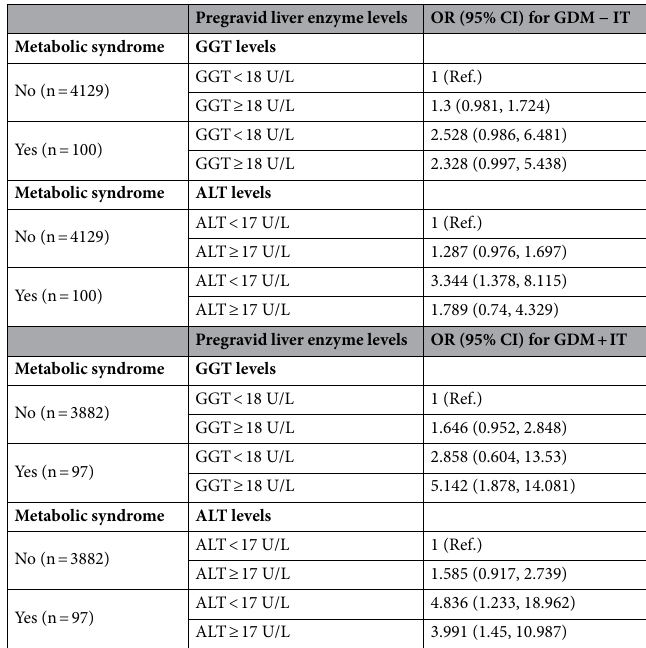
Table 4. GDM risks in a subsequent twin pregnancy, according to pregravid liver enzyme levels and metabolic syndrome. Adjusted for maternal age, parity, smoking, alcohol consumption, income level, exercise status, and BMI. ALT alanine aminotransferase, GDM gestational diabetes mellitus, GGT gamma-glutamyltransferase, OR odds ratio, CI Confidence interval. Non-GDM pregnant women without GDM, GDM − IT GDM pregnant women without insulin treatment, GDM + IT GDM pregnant women with insulin